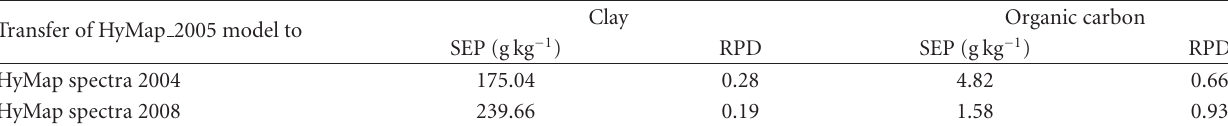
Table 6: Validation performance statistics of HyMap 2005 model transfers to HyMap spectra from di ff erent acquisition years. Transfer of HyMap 2005 model